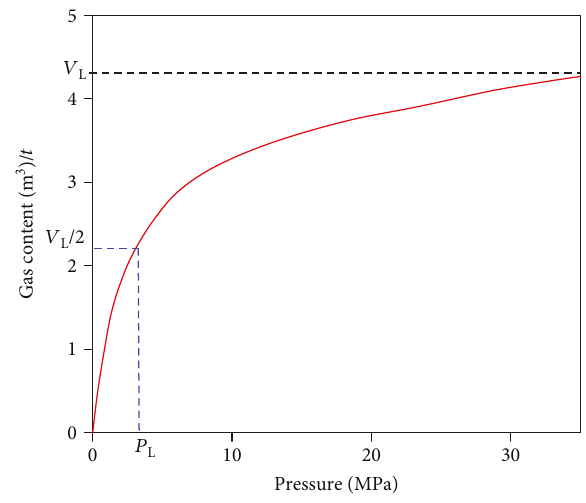
Figure 1: Langmuir adsorption